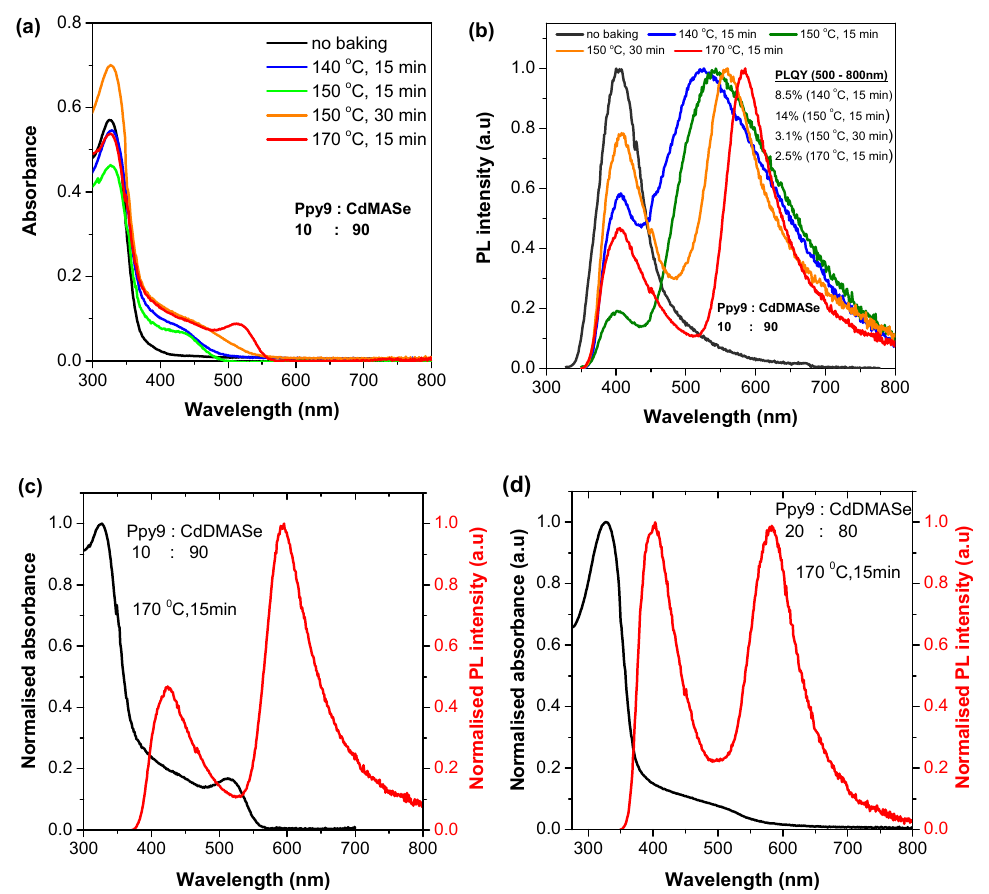
Figure 2. ( a , b ) Absorption and PL spectra of Ppy9 and CdDMASe blend film before and after baking at 140 ◦ C for 15 min, 150 ◦ C for 15 min and 30 min, and 170 ◦ C for 15 min. PL spectra were obtained using excitation wavelength of 330 nm in all cases. ( c , d ) Absorption and PL spectra of blends of Ppy9 and CdDMASe with different blend ratios. The films were annealed at 170 ◦ C for 15 min.